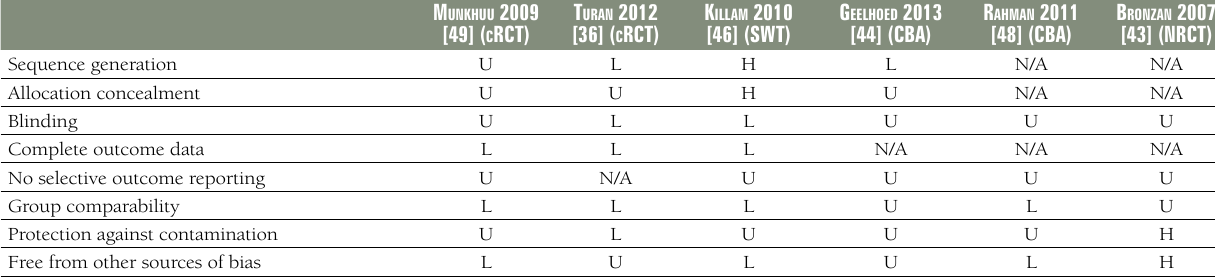
Table 2. Risk of bias assessment (EPOC criteria) of included RCTs, SWTs, CBAs and